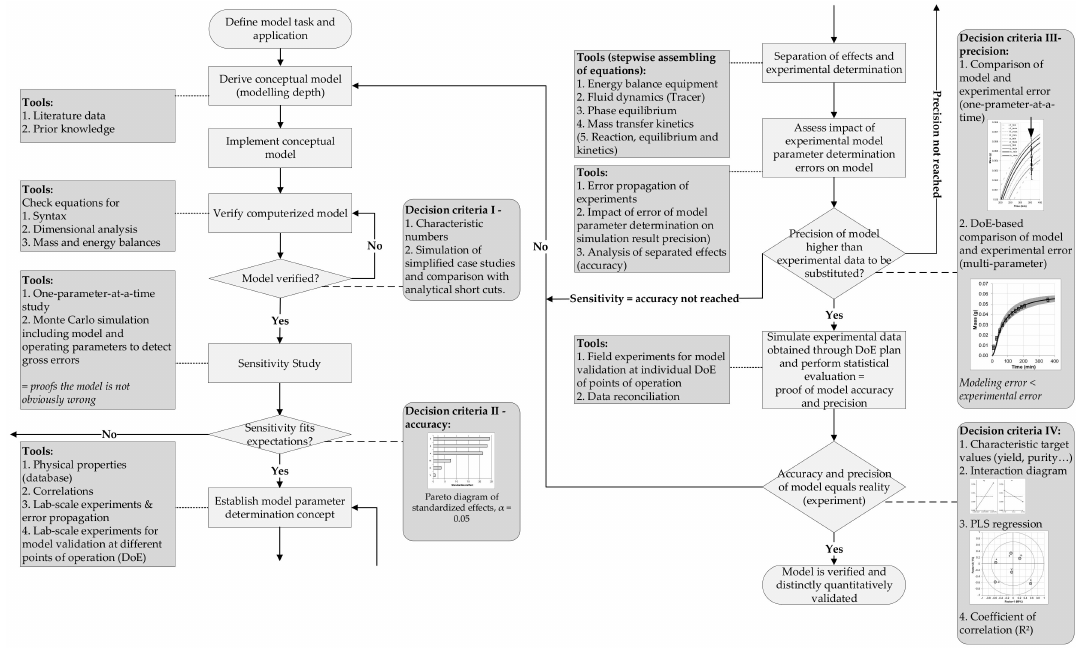
Figure 2. Process design and operation model validation method